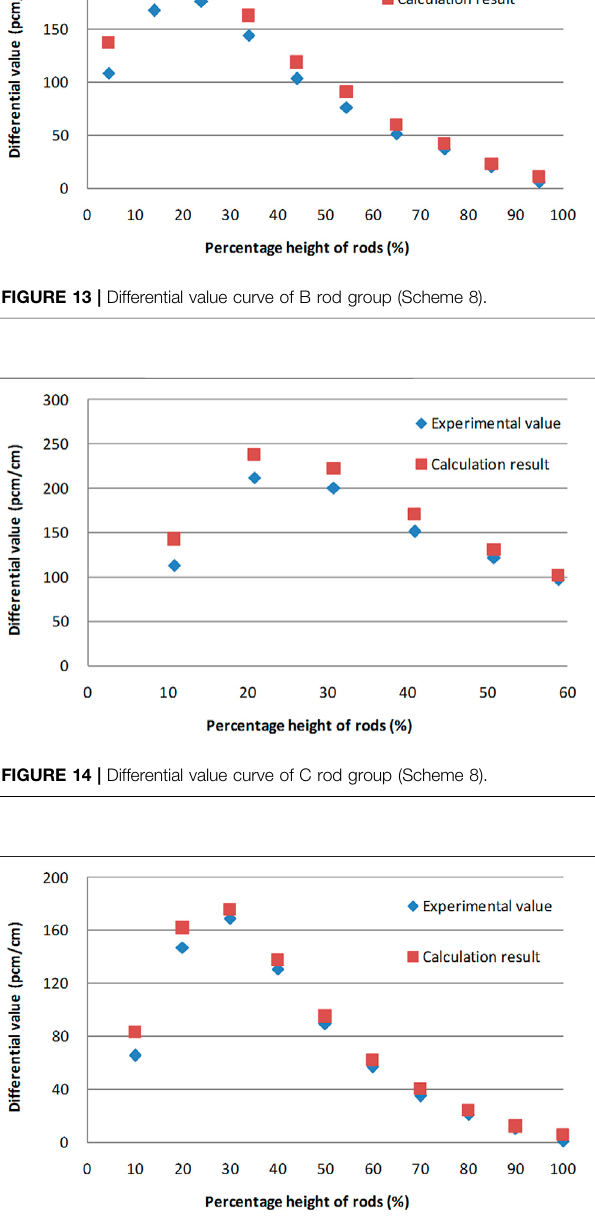
FIGURE 15 | Differential value curve of B rod group (Scheme